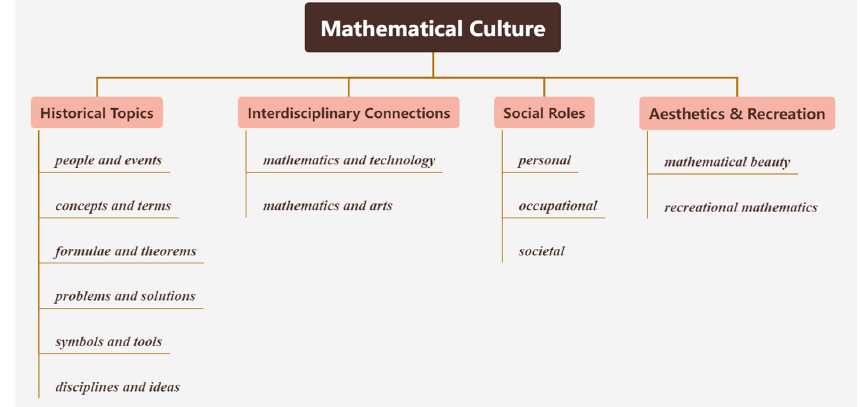
Figure 1. A conceptual framework for the analysis of mathematical culture based on Gaokao items.